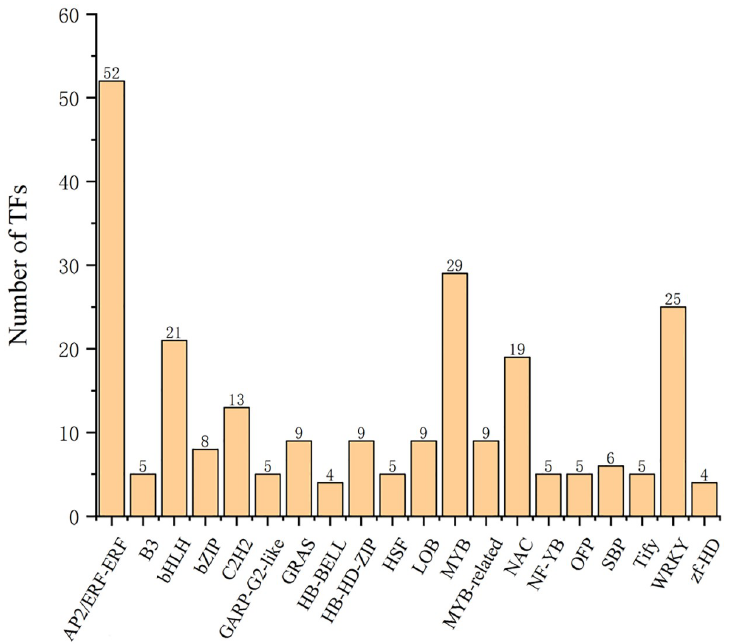
Fig 4. Enrichment analysis of DEGs. Top 20 pathways enriched in KEGG. The X-axis indicates the rich factor, and the Y-axis indicates the KEGG pathway. The larger the rich factor is, the higher the degree of enrichment. Q-value range, 0 to 1; the closer to zero the value is, the more significant the